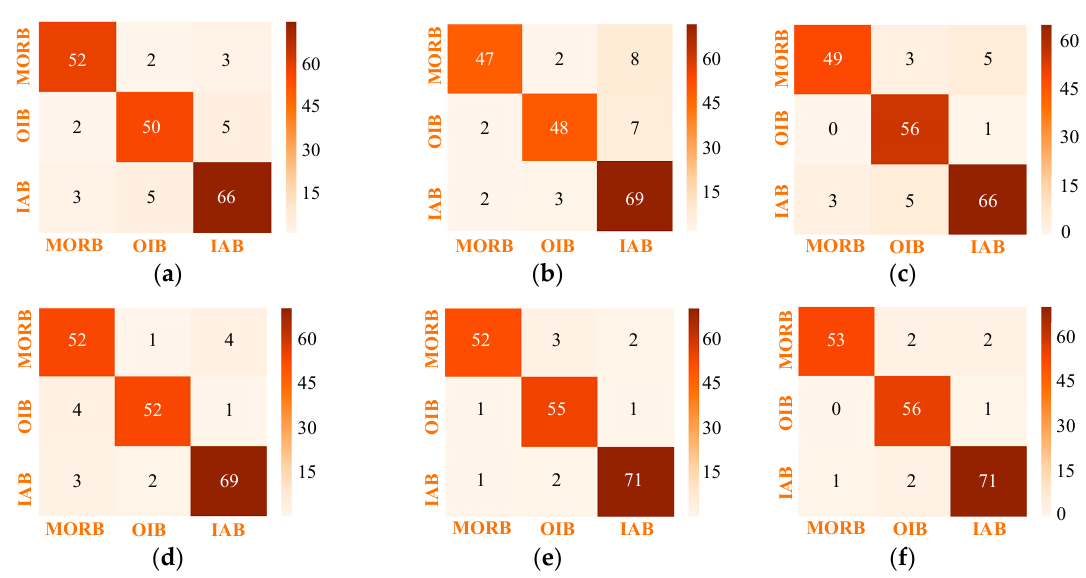
Figure 6. Confusion matrix visualization of tectonic discrimination of basalts in dataset 1 based on different MLAs: ( a ) logistic regression classifier (LRC); ( b ) naïve Bayes (NB); ( c ) multilayer perceptron (MLP); ( d ) support vector machine (SVM); ( e ) random forest (RF) and ( f ) SONFIS.